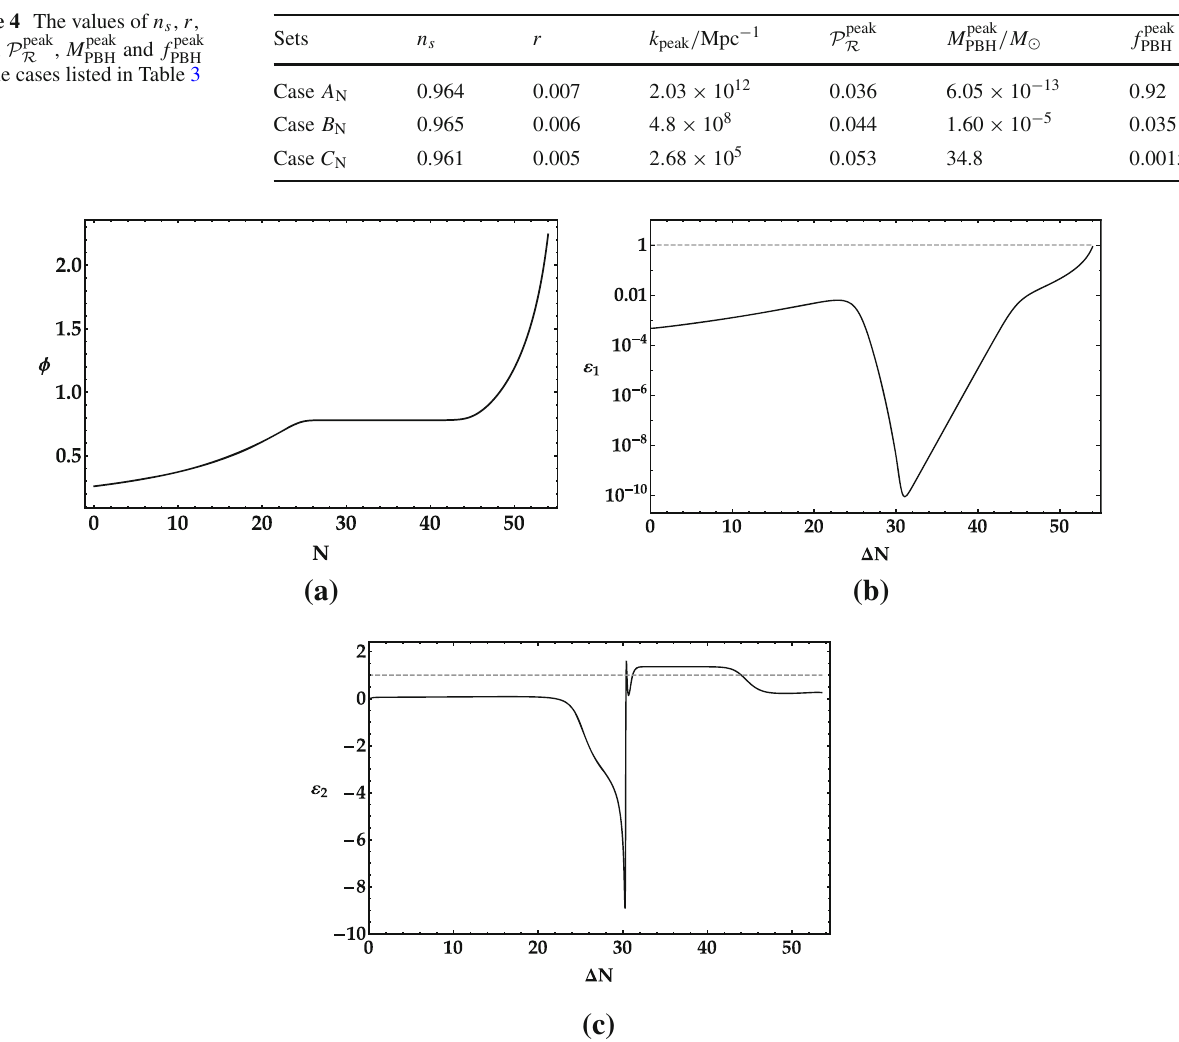
Fig. 3 Same as Fig. 3, but for the natural inflation model. The auxiliary parameters are given by the parameter set of case A N in Table 3 and we take N ∗ = 0 at the horizon exit